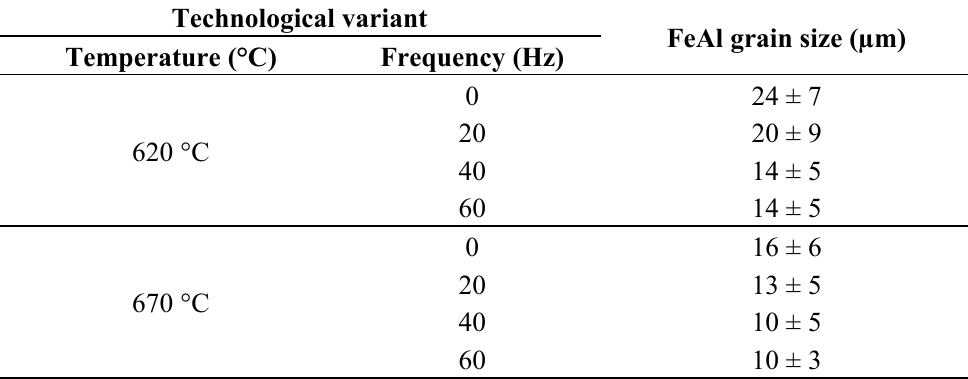
Table 1. Average equivalent diameter of FeAl grains after various technological